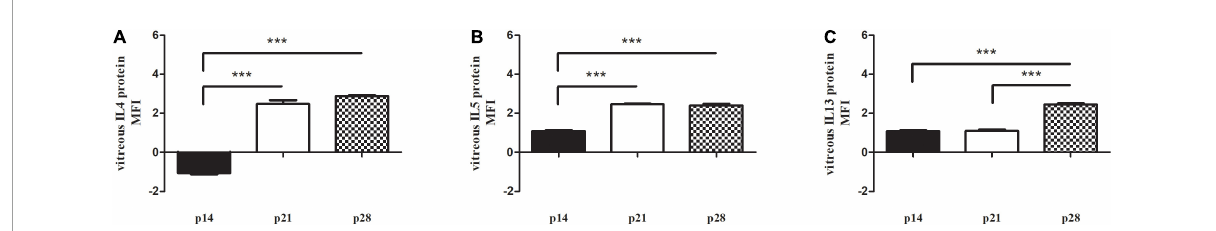
FIGURE9 Vitreal signature in Reeler mice. Chip array analysis was performed on prediluted vitreal samples from Reeler (RL) and WT mice. Bar plots representative of modulators of (A) IL4, (B) IL5 and (C) IL13 proteins, as detected by Axon software after fluorescence acquisition (Genepix) at p14, p21 and p28, as compared to WT. Note the selective increased expression at p28. Fold changes [ ± 2 FC, from data supplied as Mean Fluorescence Intensity (MFI)] and p values were calculated as initial cut-off (*** p < 0.001; two-sided unpaired t -test statistical comparisons with Bonferroni